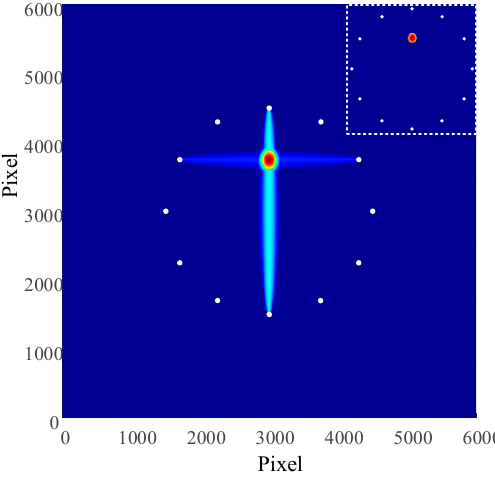
Figure 6. Damage imaging results.